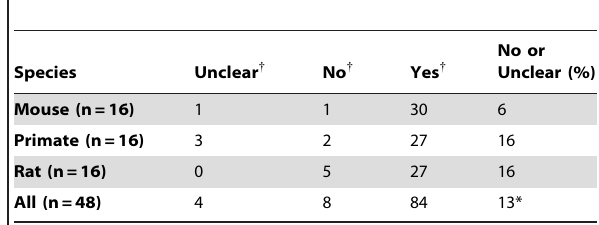
Table 5. Number of studies that clearly identified the experimental